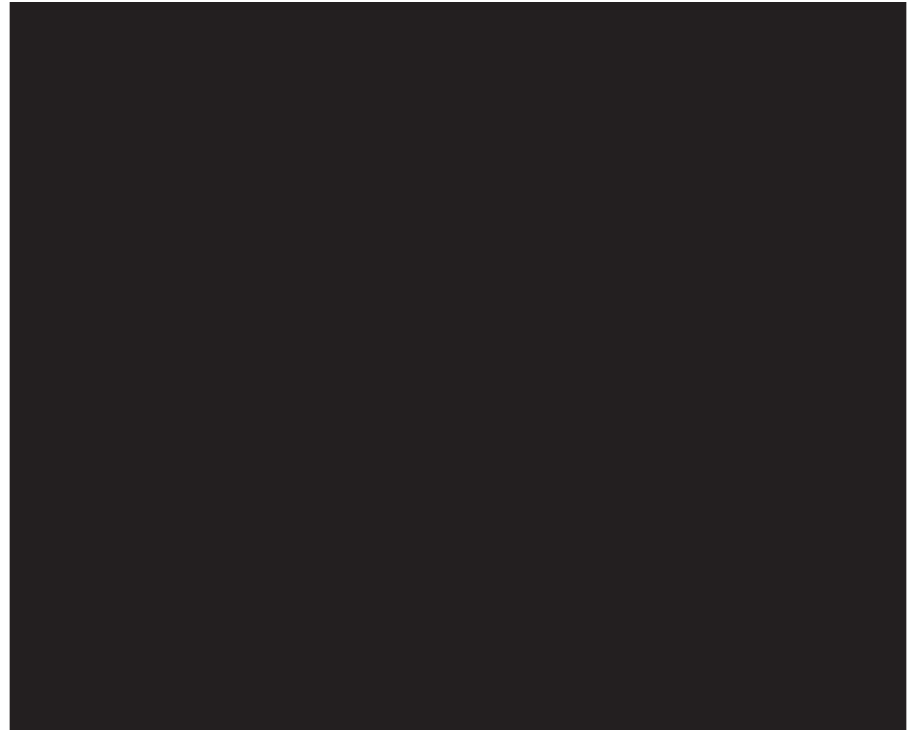
Figure 4: Distribution of dams in China.